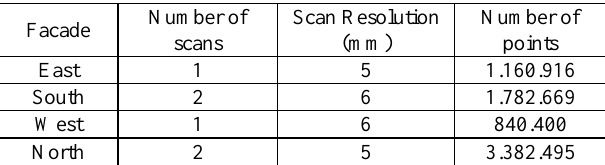
Table 7. Laser scanner measurements.